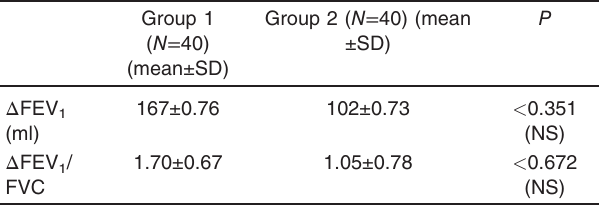
Table 6 Comparison between group 1 and group 2 regarding post-treatment change in spirometric parameters